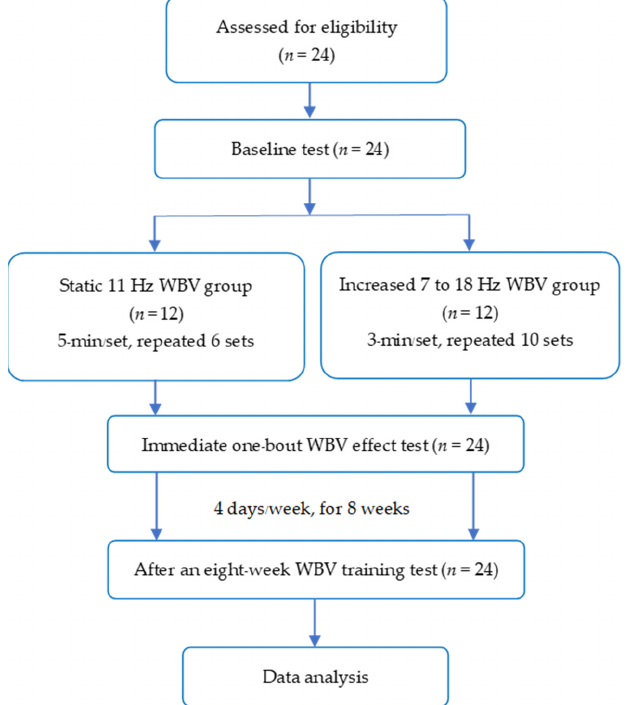
Figure 1 . The participant ’ s flow chart . SVF, static vibration frequency; IVF, increased vibration Figure 1. The participant’s flow chart. SVF, static vibration frequency; IVF, increased vibration frequency; WBV, whole - body vibration . frequency; WBV, whole-body